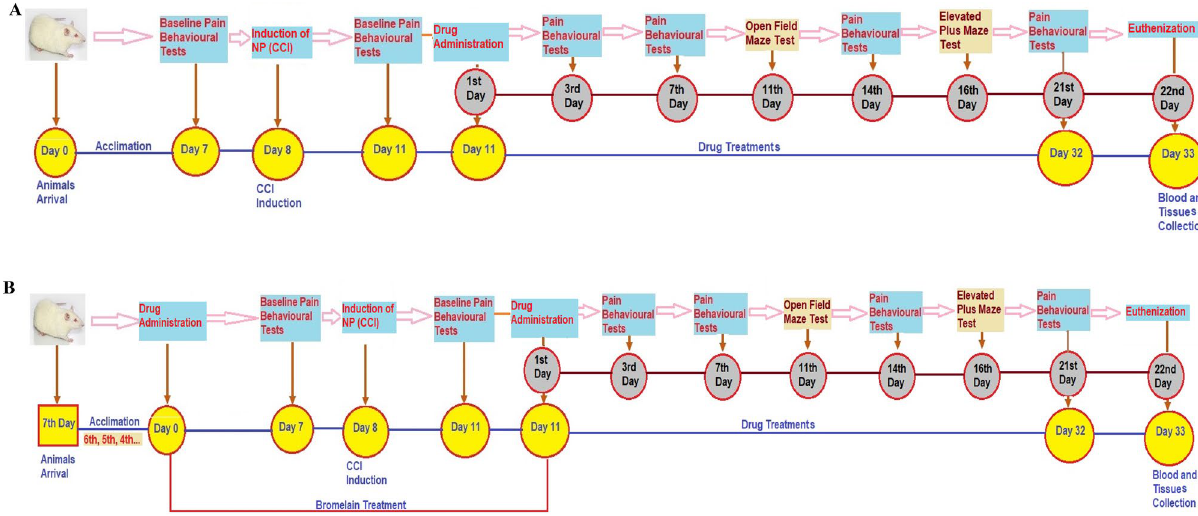
Figure 1. Schematic representation of drug treatments and behavioural tests schedule. ( A ) Post-treatment schedule. ( B ) Pre-treatment disorders, only a few studies have a focus on the enormous role of pro-inflammatory cytokines in the emotional disturbances associated with neuropathic pain. Bromelain is a cysteine proteolytic enzyme. It is well known for its chemoprotective, wound healing, systemic anti-inflammatory, and anticancer effects 19–21 . Antinociceptive effects of bromelain have also been reported in osteoarthritic pain 22 , preoperative third molar pain 23 , and perineal pain 21 . Recently, we reported the antinocic- eptive effect of bromelain in the chronic constriction injury model of neuropathic pain 24 . Our previous studies show that bromelain inhibited thermal hyperalgesia and improved mechanical allodynia and sciatic functional index. However, the mechanisms involved are yet to be fully understood, which is why this study was under- taken. Hence, this study investigated the anti-inflammatory mechanisms which might be contributing to the antinociceptive and anti-comorbidity effects of bromelain in a chronic constricted injury model of neuropathic pain in Wistar rats.